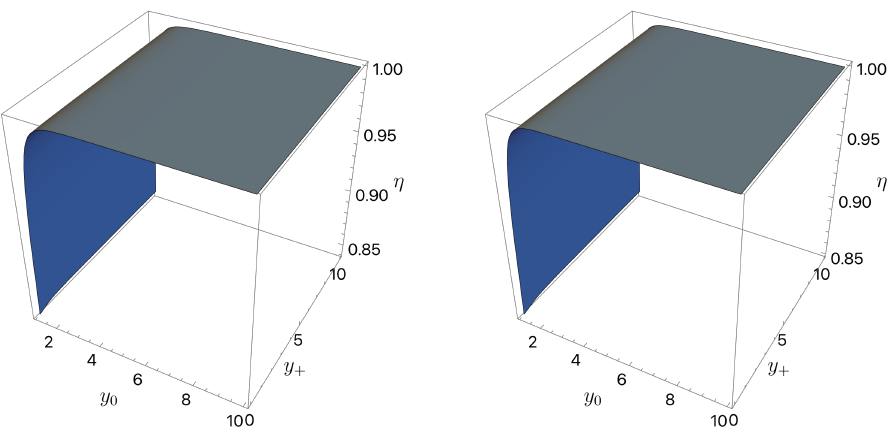
Figure 2 . η , defined in (3.28), as a function of y 0 and y + for d = 4 (left panel) and d = 5 (right panel). From the positivity of η we conclude that the norm of the lowest lying mode is positive definite, and as such no Wick rotation is